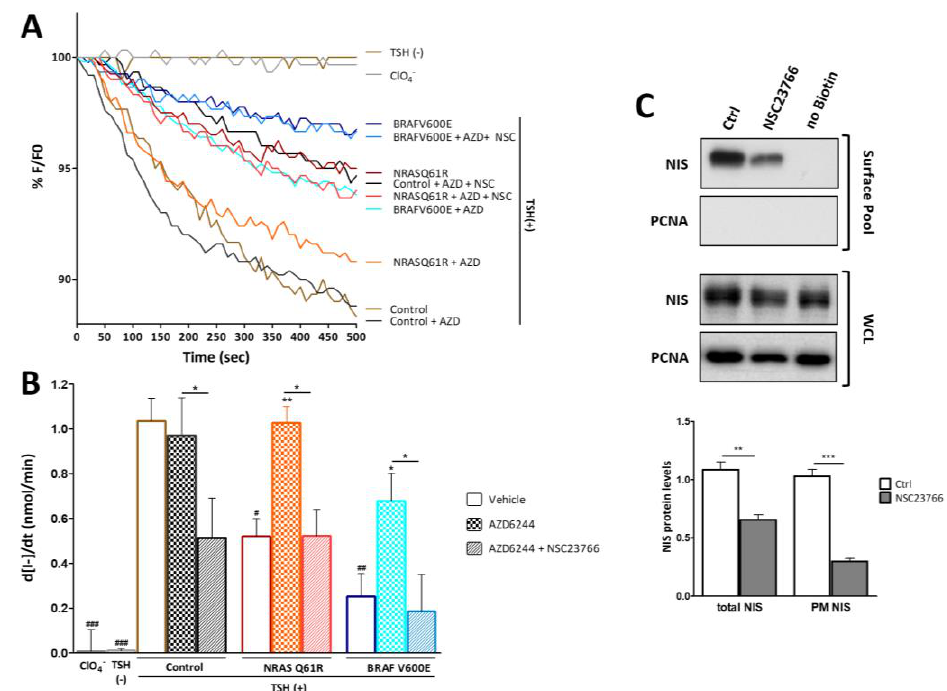
Figure 5. Impact of MEK and RAC1 signaling on endogenous NIS levels at the plasma membrane and NIS-mediated iodide uptake in PCCL3 cells. PCCL3 cells stably expressing the YFP-halide sensor were either mock transduced (control) or transduced with NRAS Q61R or BRAF V600E constructs, subjected to a 24 h starvation period and then treated with TSH for 96 h in the presence or absence of AZD6244 (10 µM for 48 h), alone or in combination with NSC23766 (100 µM for 24 h). YFP fluorescence was recorded continuously for 500 s, acquiring an image every 10 s, after exposure to 1 mM NaI. ( A ) Fluorescence (F) was plotted over time as percentage of fluorescence at time 0 (F 0 ). Shown are representative fluorescence decay curves for each experimental condition. ( B ) Iodide influx rates calculated by fitting the curves to the exponential decay function to derive the maximal slope that corresponds to initial I − influx rates. Data are means ± SEM of at least three independent assays. One-way ANOVA analysis detected significant differences between treatments (F = 8.79 and p < 0.0001). Post-hoc Tukey’s tests were used to identify significant variations relative to either TSH-stimulated, mock-transduced, untreated (vehicle) cells (# p ≤ 0.05, ## p ≤ 0.01 and ### p ≤ 0.001) or among equally transduced, TSH-stimulated cells treated with the indicated compounds (* p ≤ 0.05; ** p ≤ 0.01). ( C ) PCCL3 cells were treated with TSH for 48 h in the presence or absence of NSC23766 (100 µM for 24 h). Cell surface proteins were biotinylated and both whole-cell lysates (WCL) and surface protein fraction were analyzed by western blot to detect endogenous NIS protein, using α -NIS primary antibody (see Figure S3 for uncropped WB). The ‘no Biotin’ condition, corresponding to cells that were not incubated with biotin, was used as control for non-biotinylated protein capture. PCNA expression served as loading (WCL) and intracellular protein contamination control (Surface pool). WB bands were quantified by densitometry analysis using Image J software (NIH, Bethesda, MD, USA). Comparisons between Ctrl or NSC23766-treated cells were made using a two-tailed Student’s t -test (** p ≤ 0.01; *** p ≤ 0.001).